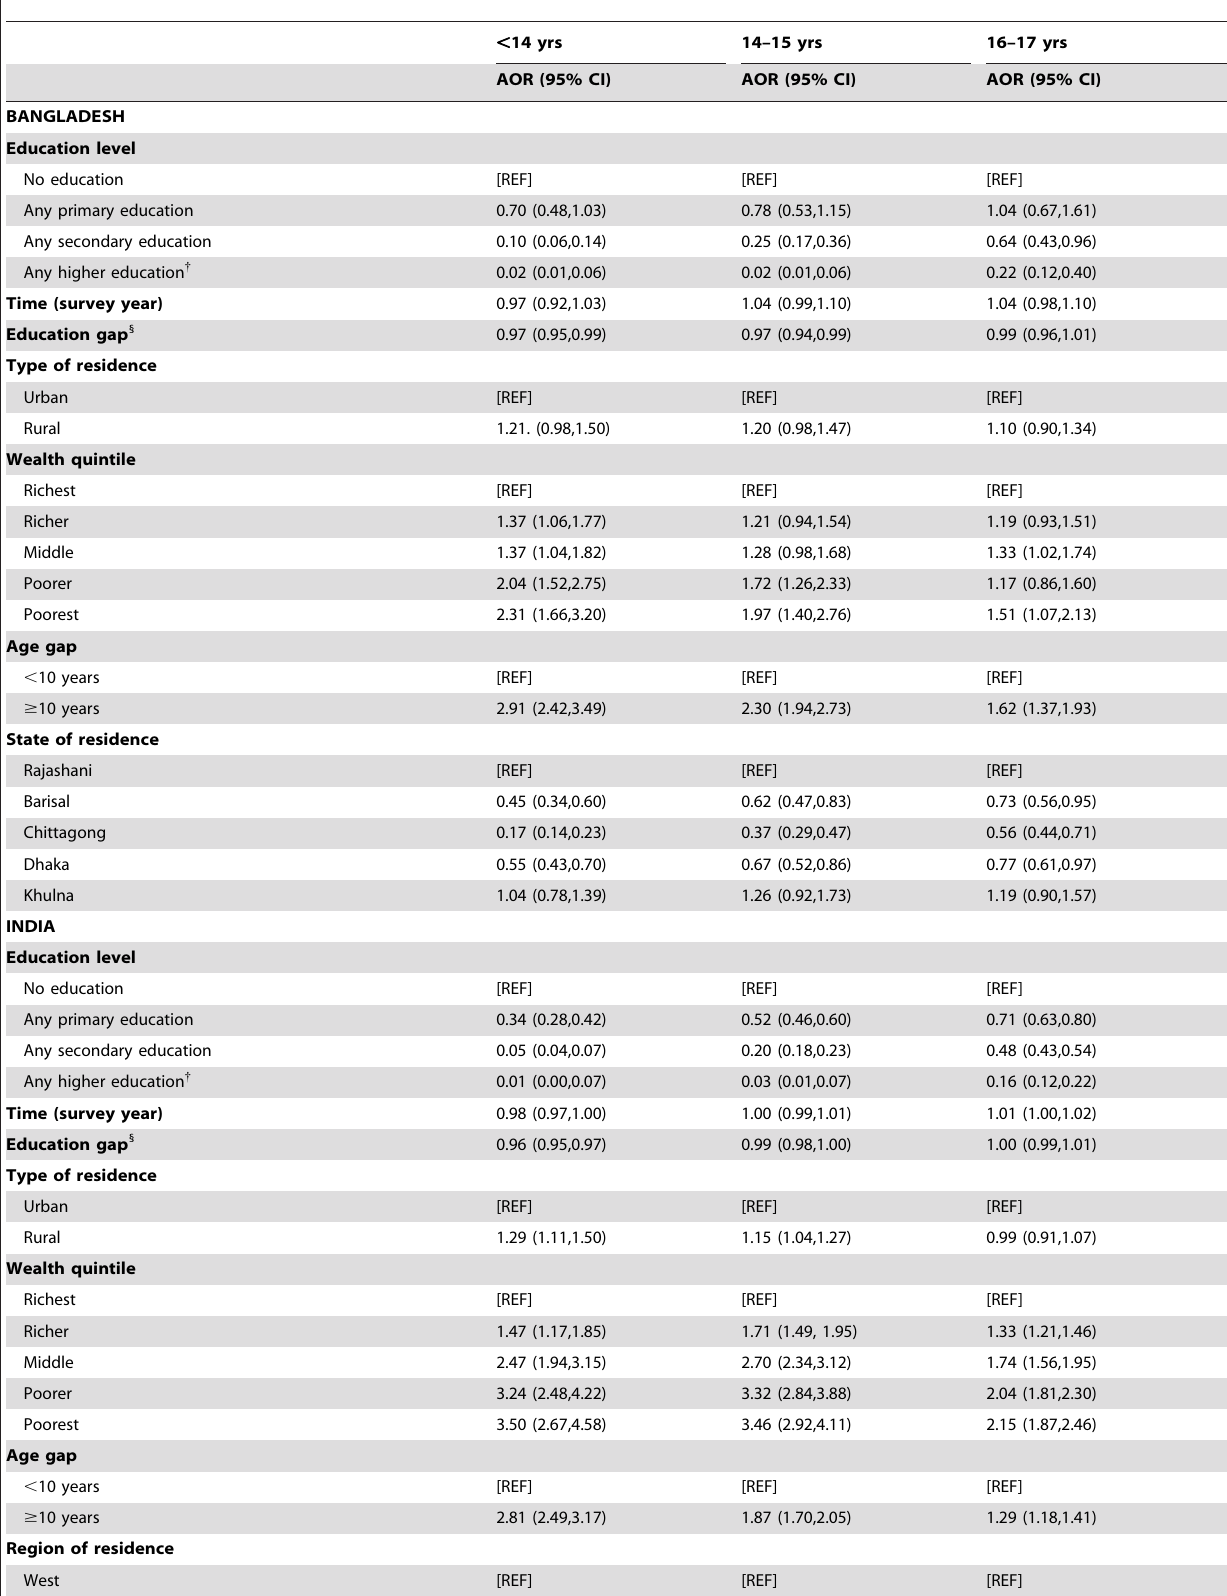
Table 2. Multinomial model assessing odds of marrying at ages , 14, 14–15, 16–17, compared to marrying at 18 or older in Bangladesh, India, Nepal and